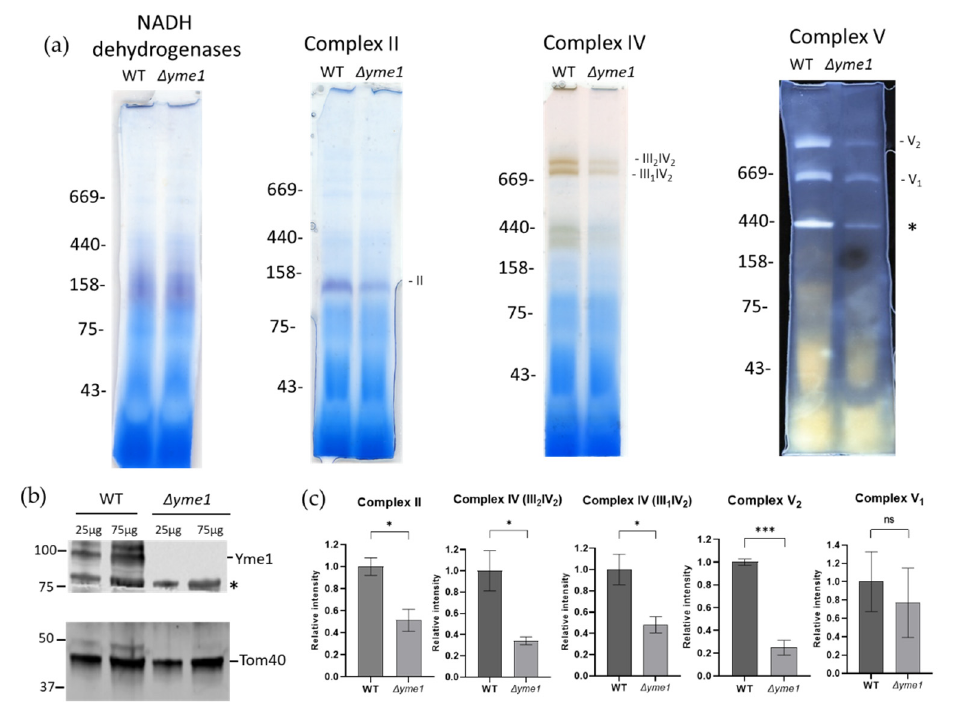
Figure 7. In-gel analysis of effect of YME1 deletion on mitochondrial OXPHOS complex activities using mitochondria isolated from cells grown in YPGal. ( a ) Blue-native PAGE based in-gel activity assays for mitochondrial NADH dehydrogenases, and complex II, IV and V, as indicated. Mitochondria were isolated from WT and Δ yme1 cells grown in YPGal at 30 °C. In each lane, 50 μ g of mitochondria proteins were loaded. Complex II, complex IV in super-complex III 2 IV 1 , III 2 IV 2 and complex V in monomer (V 1 ) and dimer (V 2 ) are indicated, and the * indicates an unknown band. ( b ) Western blots with antibodies against mitochondrial Yme1 and Tom40, respectively. WT and Δ yme1 mitochondrial proteins (25 and 75 μ g) were separated using reducing SDS-PAGE, then blotted against antibodies for specific protein as indicated. The * indicates a nonspecific band. (c) Quantification of the relative activities of the complexes (II, III/IV, V) as shown in A. The error bars represent SEM of three independent experiments with the same mitochondrial preparation (n = 3). The statistic was done using Student’s t test, ns p > 0.05; * p < 0.05;; *** p <